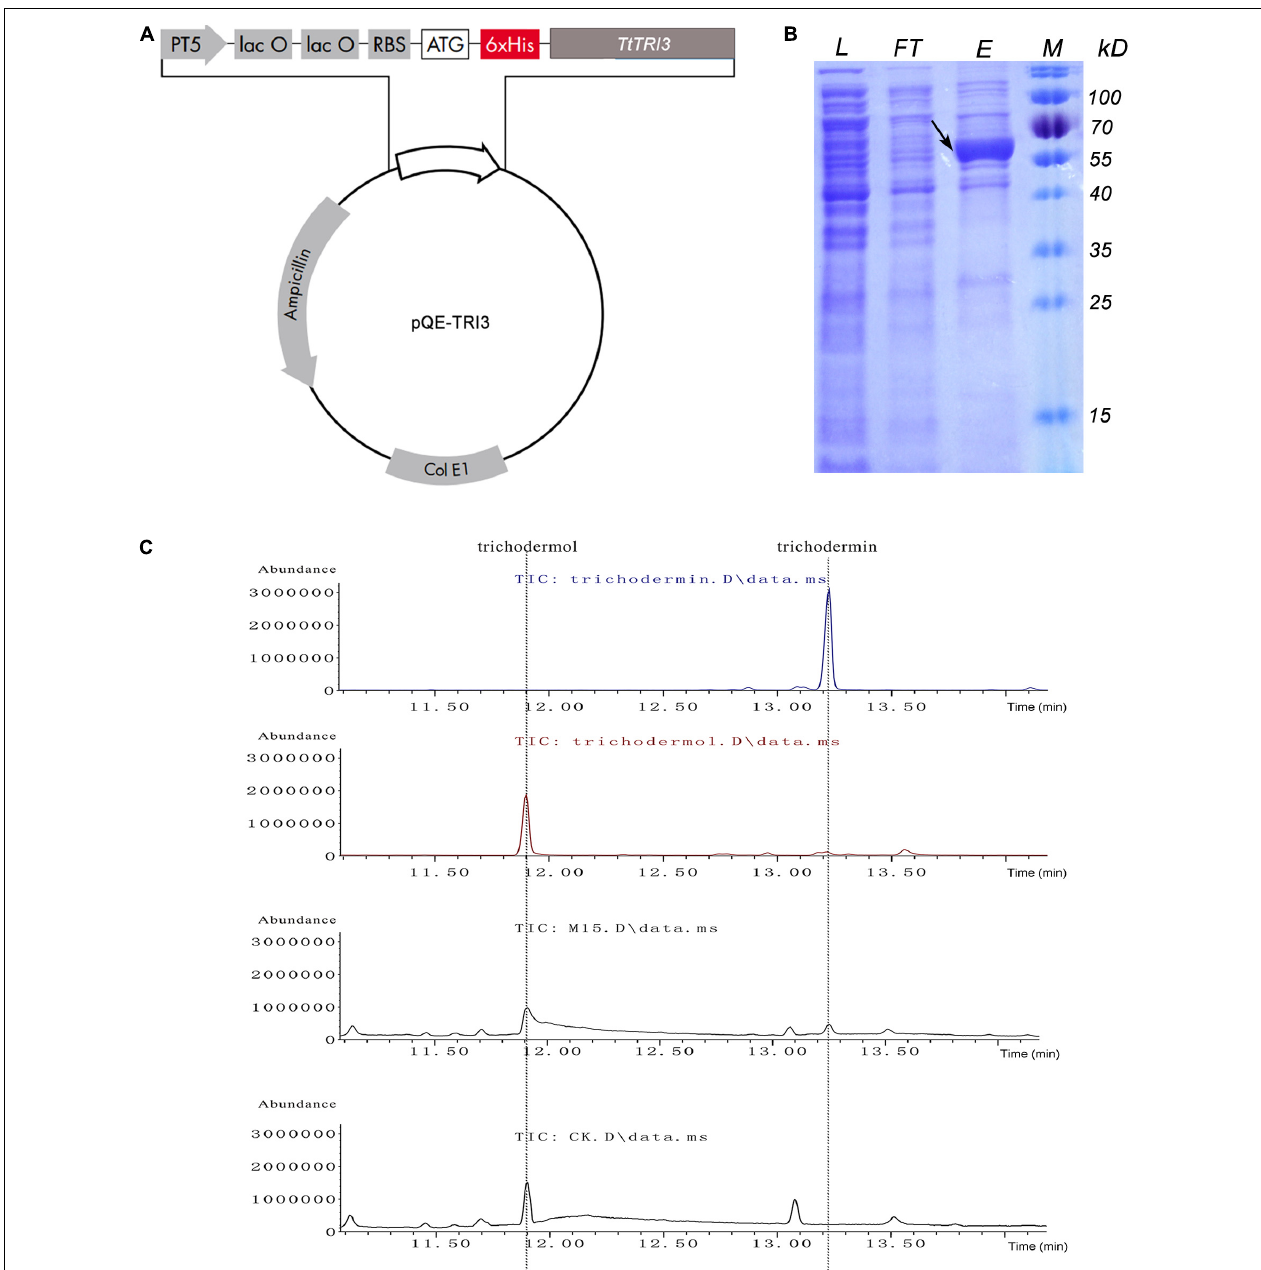
FIGURE 6 | In vitro conversion of trichodermol to trichodermin catalyzed by bacterial expressed Tt TRI3. (A) The structure of the constructed plasmid for expression of Tt TRI3. The 6xHis tag was engineered to fuse immediately upstream of the Tt TRI3 coding region. (B) Sodium dodecyl sulfate–polyacrylamide gel electrophoresis (SDS-PAGE) shows the purification of Escherichia coli -expressed Tt TRI3. The black arrow indicates the band of the target protein. The molecular weight (MW) of this band on the gel is consistent with the calculated theoretical MW, 60 kDa. L: cell lysate; FT: flowthrough from Ni-NTA column after cell lysate was loaded; E: eluate from Tt TRI3-bound column; M: protein marker. (C) GC-MS analysis results showed that addition of Tt TRI3 resulted in the appearance of trichodermin in reaction mixture. The upper two curves show the respective retention time of trichodermin and trichodermol. The two curves at the bottom represent curves obtained from ethyl acetate extract from trichodermol reaction mixture, with combination of either Tt TRI3 (sample M15) or cell lysate prepared from Escherichia coli cell bearing empty vector pQE30 (sample